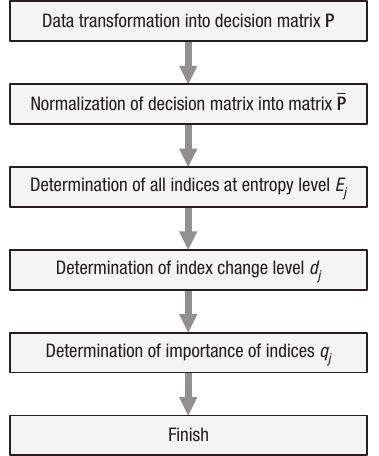
Data transformation into decision matrix P